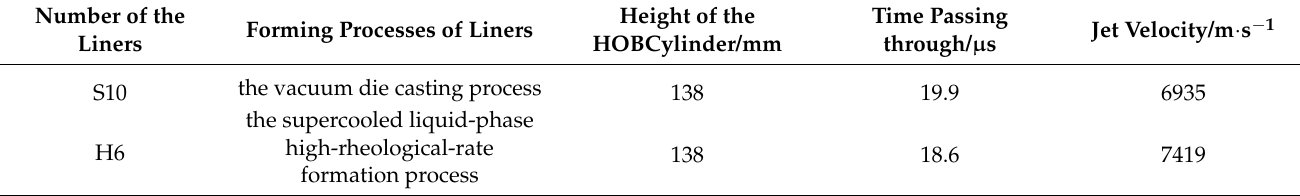
Table 6. Test results of copper foil target velocity-measuring system.